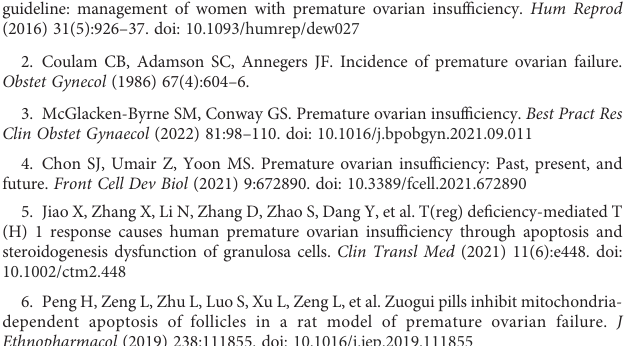
SUPPLEMENTARY FIGURE 2 The original bands for b -actin. SUPPLEMENTARY FIGURE 3 The original bands for Beclin 1. SUPPLEMENTARY FIGURE 4 The original bands for p62. SUPPLEMENTARY FIGURE 5 The original bands for parkin. SUPPLEMENTARY FIGURE 6 The original bands for PINK1. SUPPLEMENTARY FIGURE 7 The original bands for LC3. SUPPLEMENTARY FIGURE 8 The original bands for NLRP3. SUPPLEMENTARY FIGURE 9 The original bands for GSDMD. SUPPLEMENTARY FIGURE 10 The original bands for caspase-1. SUPPLEMENTARY FIGURE 11 The original bands for IL-18. SUPPLEMENTARY FIGURE 12 The original bands for IL-1 b